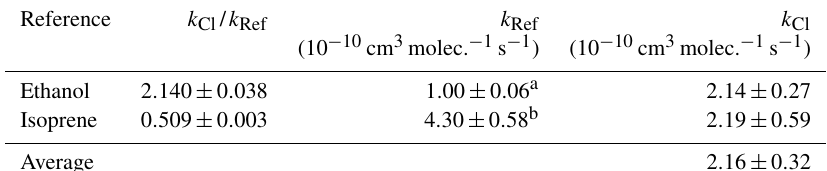
Table 4. Results obtained in the kinetic experiments for the gas-phase reaction of Cl with 2-methylbutanal at 298 ± 2K and 760 ± 5Torr of